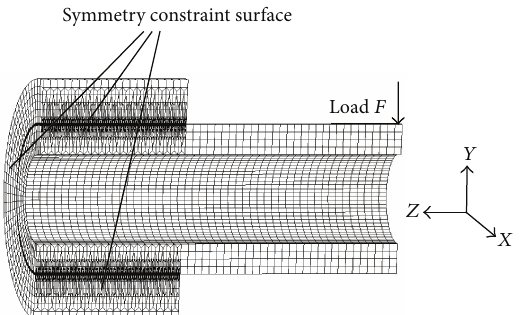
Figure 3: Finite element model of hollow shaft and bush.